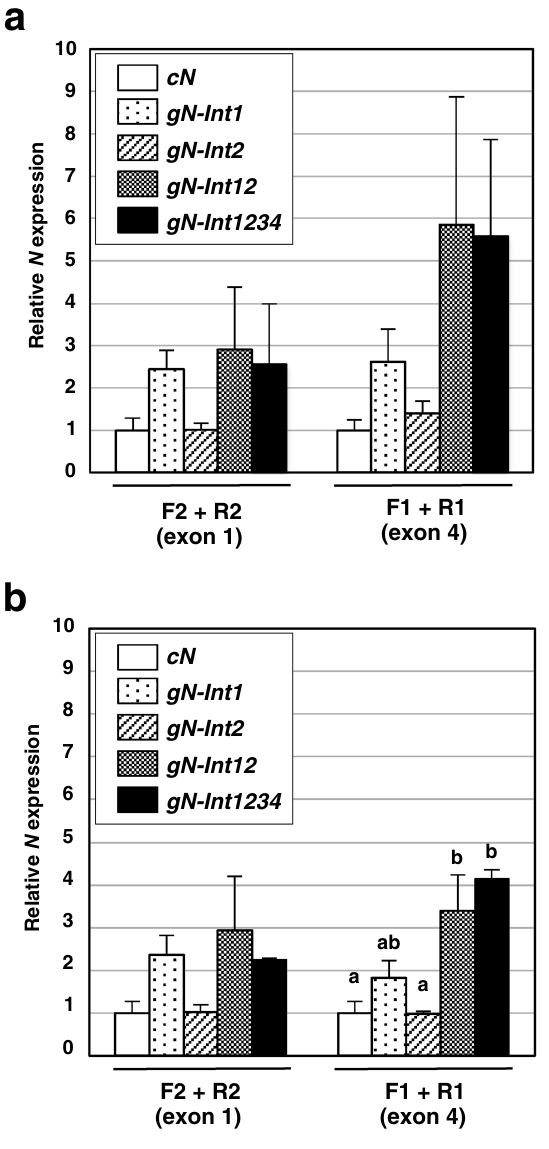
Figure 4. Introns 1 and 2 cooperatively contribute to produce more N transcripts containing the 3-proximal region within the open reading frame. Agrobacterium transformants carrying a plasmid for cN , gN-Int1 , gN-Int2 , gN-Int12 , or gN-Int1234 were infiltrated to nn tobacco. The 5 ′ - and 3 ′ -proximal regions of the N transcript open reading frame at 36 ( a ) and 48 ( b ) h post-infiltration were quantified by RT-qPCR with the F2 + R2 primer set amplifying a portion of exon1 and the F1 + R1 primer set amplifying a portion of exon 4. The transcript levels of cN were adjusted to 1 with levels for other treatments relative to these values. Transcript levels of actin were used for normalization of all values in ( a , b ). Values are the means ± SE of three independent biological replicates. Data in ( a ) and those of F1 + R1 in ( b ) were analyzed by the two-way ANOVA test followed by the Tukey–Kramer test (p < 0.05). Different letters above the bars indicate the means are significantly different from each other at the 0.05 level. Absence of letters in ( a ) indicates no significant difference between treatment means obtained through amplification with either F1 + R1 or F2 + R2. Note that variances around the means for data of F2 + R2 in ( b ) were not homogeneous. For the data set, the non-parametric Steel–Dwass one-way analysis did not show significant differences in the